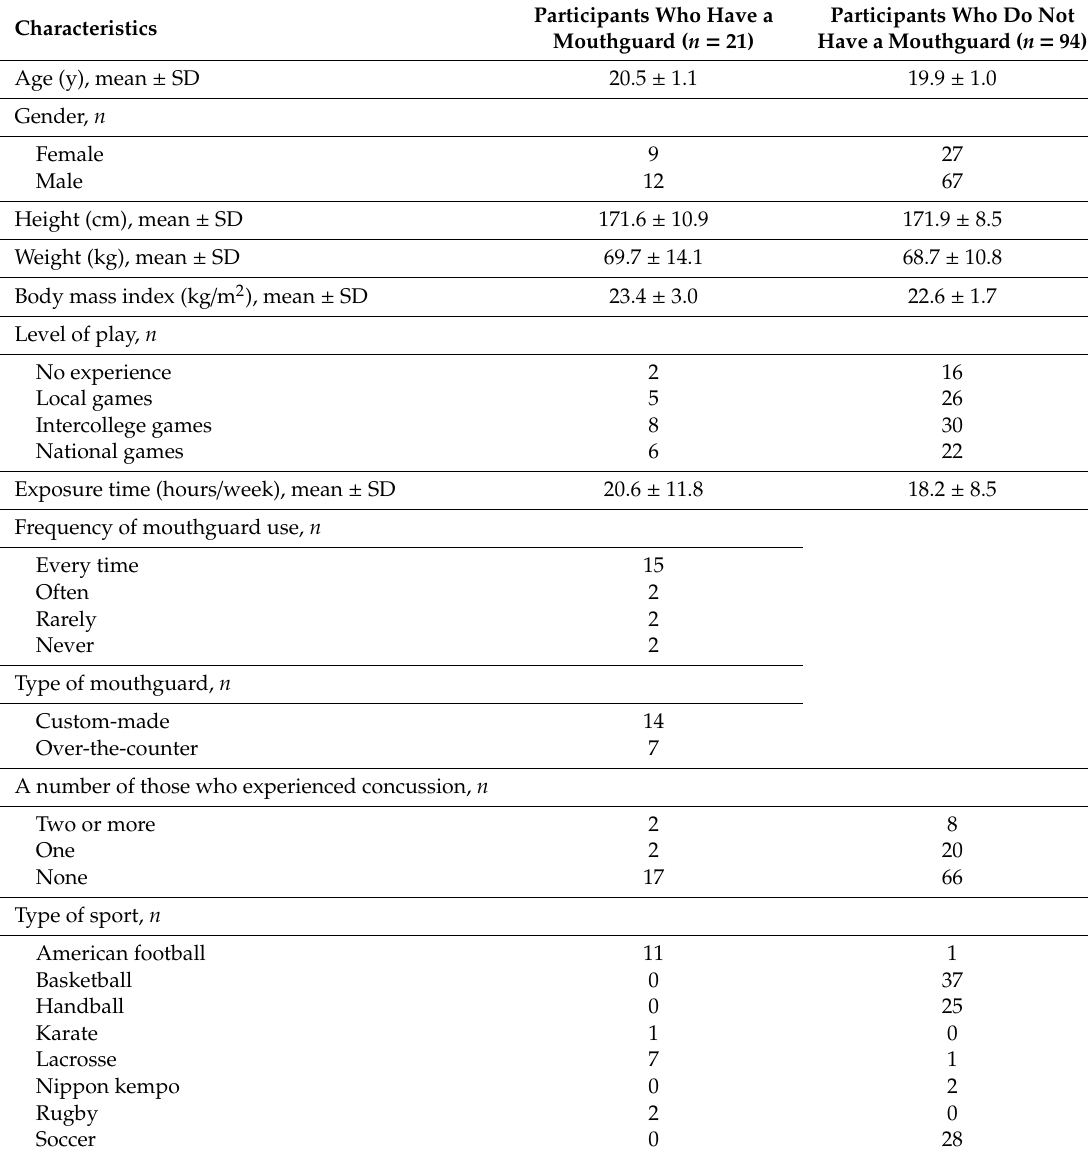
Table 1. Characteristics of the study participants ( n =